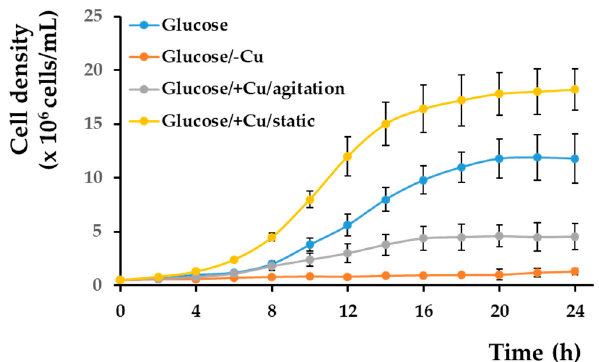
Figure 4. Growth of copper-loaded and copper-starved cells in copper-deficient medium. Wild-type strain BY4741 was pre-grown for 16 h in liquid MM/Glc (Glucose), MM/Glc without Cu (glucose/–Cu), or MM/Glc with 0.1 mM CuCl 2 under agitation (Glucose/+Cu/agitation) or for 3 days statically in MM/Glc with 0.1 mM CuCl 2 (Glucose/+Cu/static) before being washed and shifted to MM/Glc/–Cu at density 5 × 10 5 cells/mL. Cell proliferation was determined spectrophotometrically (OD 660 ) as described in Section 2. Values are mean ± SEM of triplicate determinations done on three biological repeats.